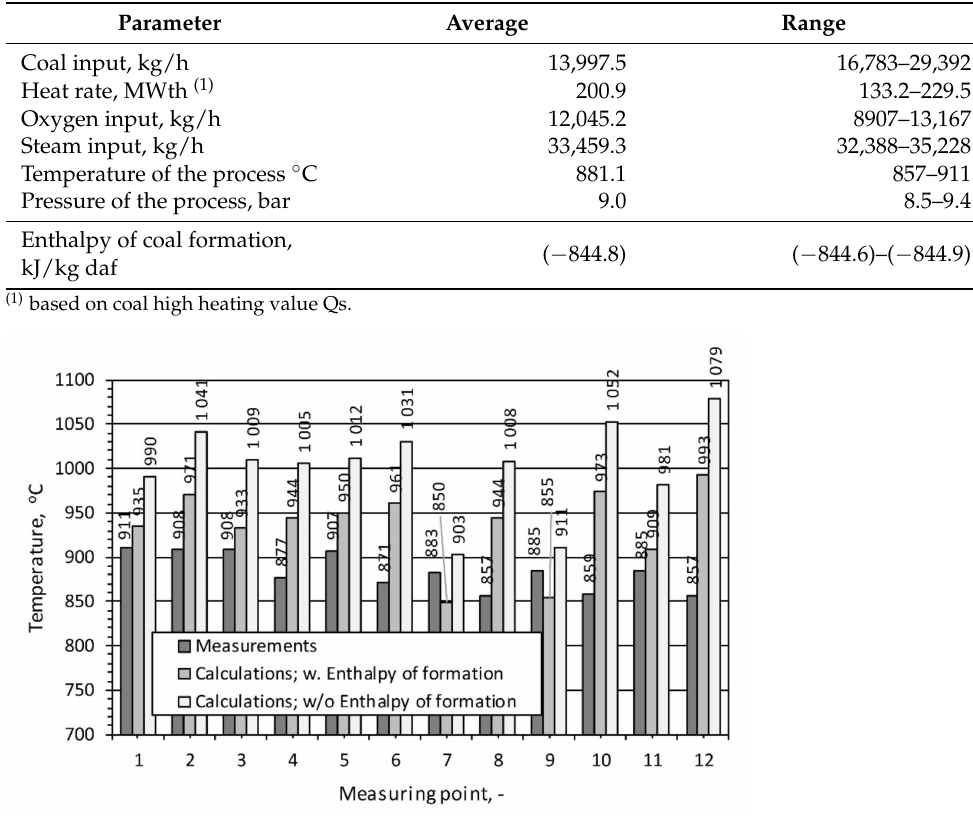
Figure 11. Difference between the actual and calculation process temperature obtained with and without the enthalpy of fuel